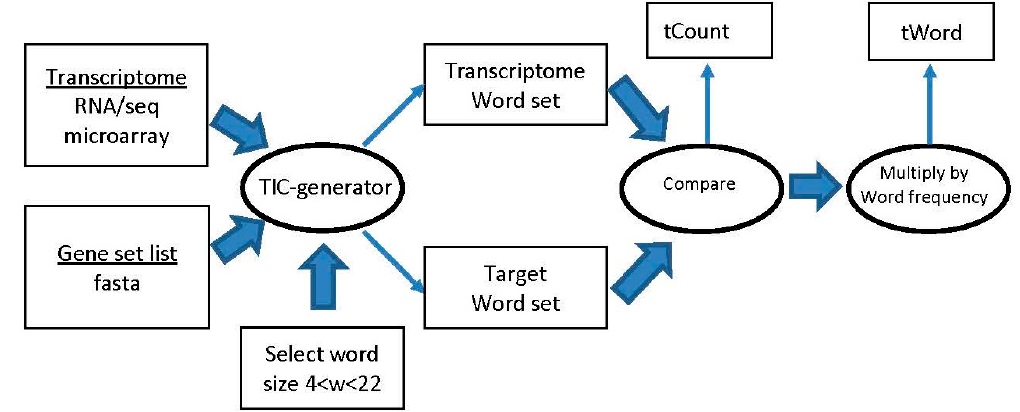
Figure 5. Logical workflow of transcriptome modeling.